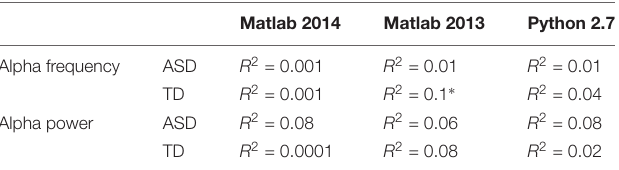
TABLE 5 | Bivariate regression analysis regarding the association of alpha characteristics (frequency and power) related to participants age. Matlab 2014 Matlab 2013 Python